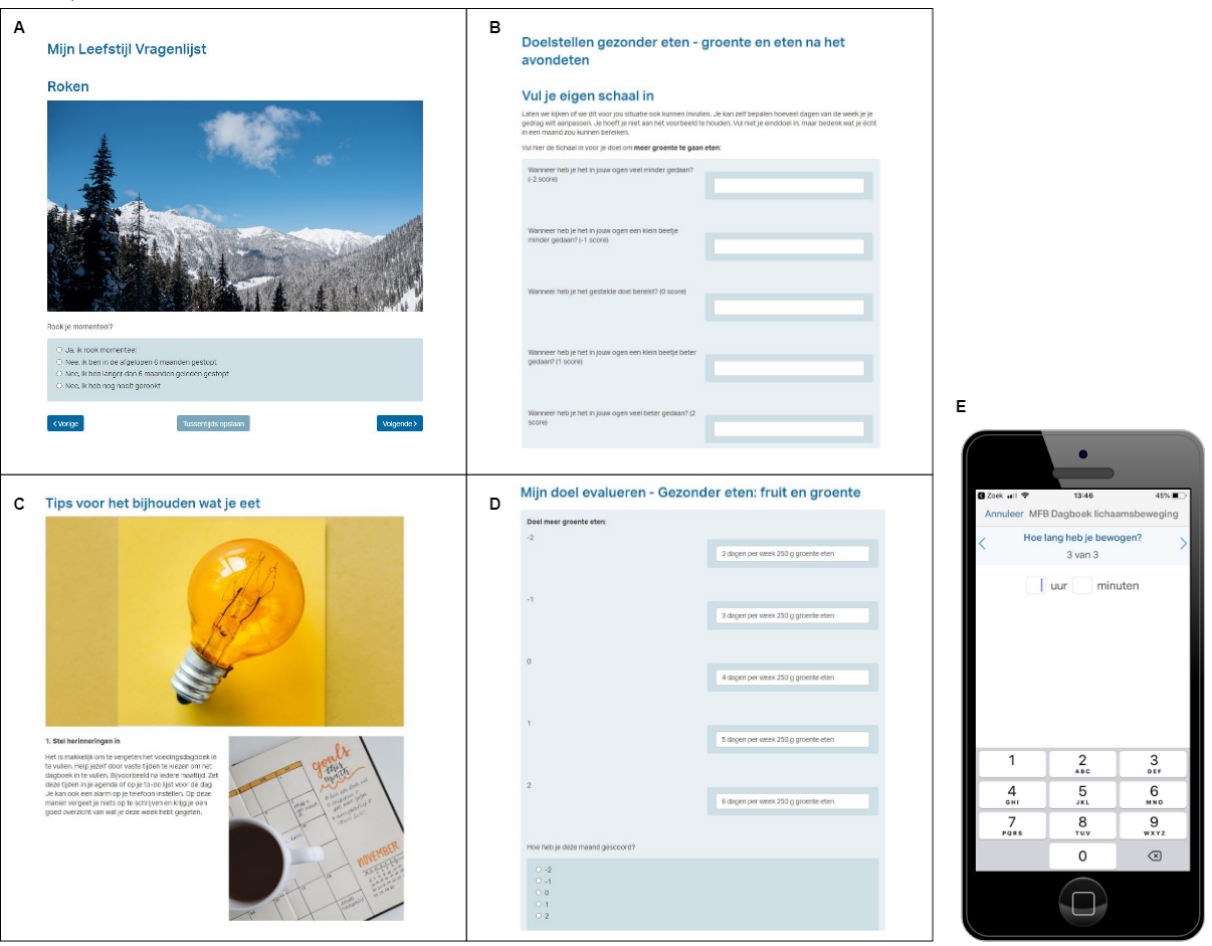
Figure 2. Screenshots showing the four steps of the MFB intervention. A: lifestyle questionnaire, B: goal setting, C: tips, D: goal evaluation, E: diary on the